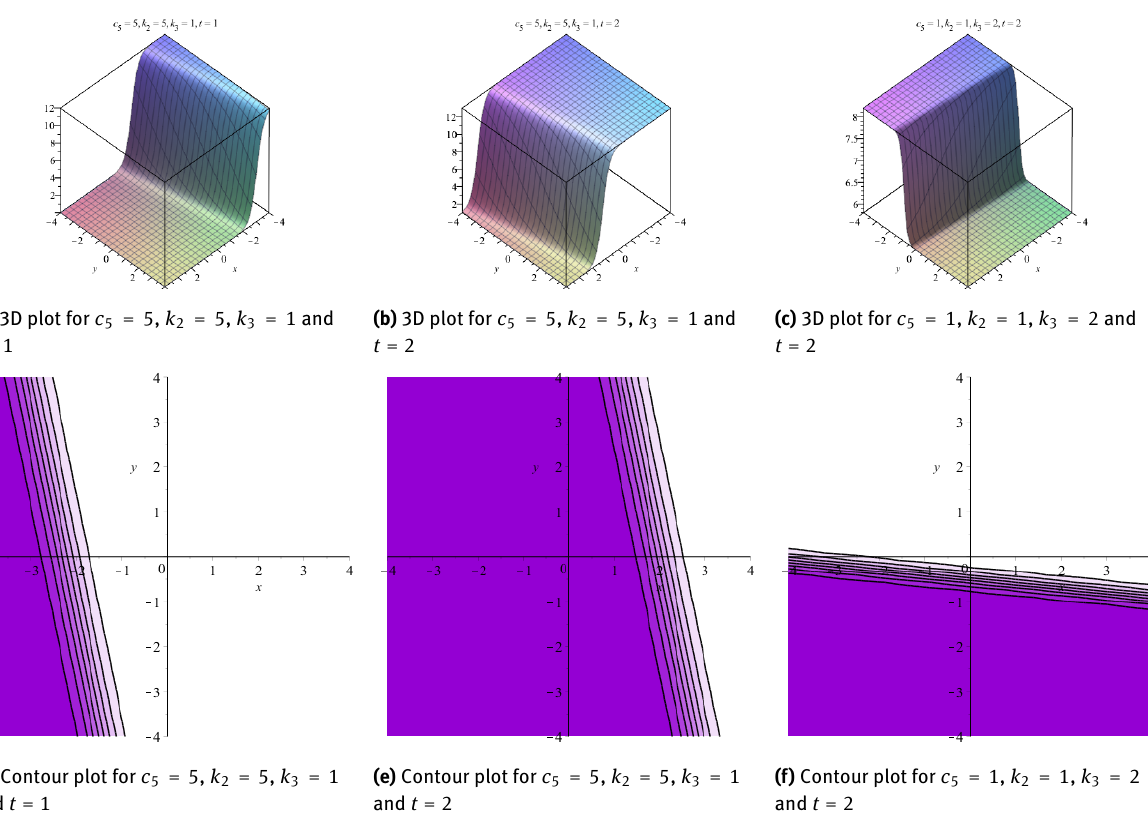
Figure 4: Solution profiles for equation (58) with c 2 = 2 , c 4 = 5 , c 6 = 5 , c 7 = 2 , k 1 = 8 , k 5 = 5 , and z = 5 .